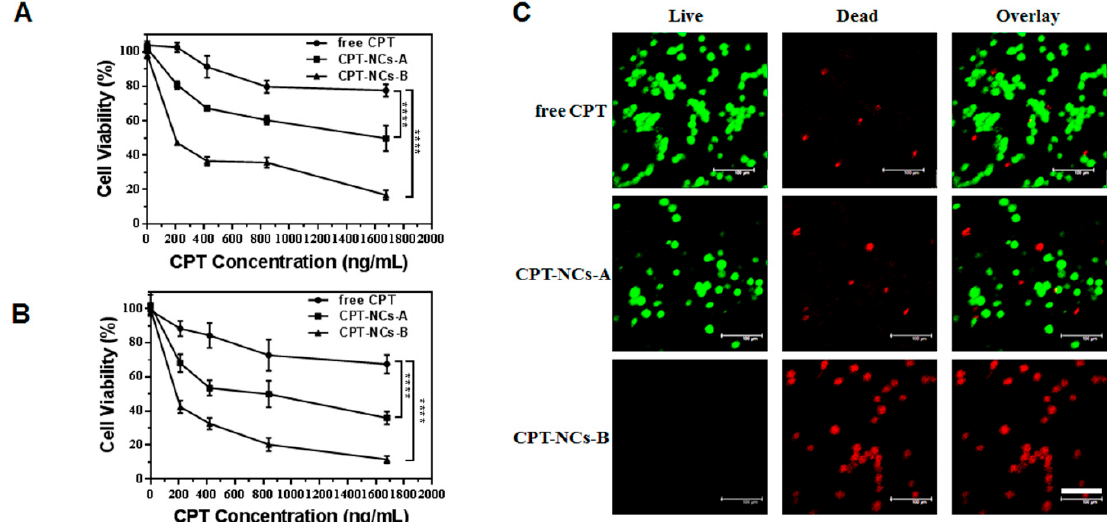
Figure 6. 3-(4,5-dimethylthiazol-2-yl)-2,5-diphenyltetrazolium bromide (MTT) assay of SCC-15 cells after treatment with free CPT, CPT-NCs-A, and CPT-NCs-B for 24 h ( A ) and 48 h ( B ). Data represent means ± SD ( n = 3), and **** p < 0.0001. ( B ) CLSM of live/dead staining (green = live cells, red = dead cells) of SCC-15 cells after treatment with free CPT, CPT-NCs-A, and CPT-NCs-B for 24 h. Scale bar = 100 μ